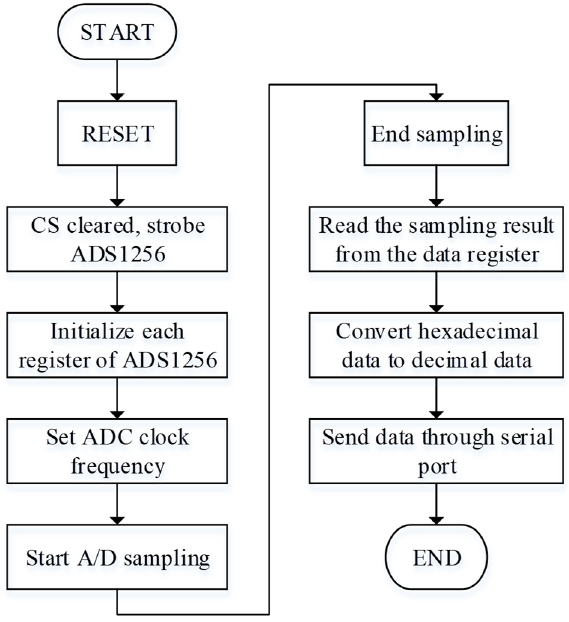
Figure 12. The flowchart of digital data acquisition.